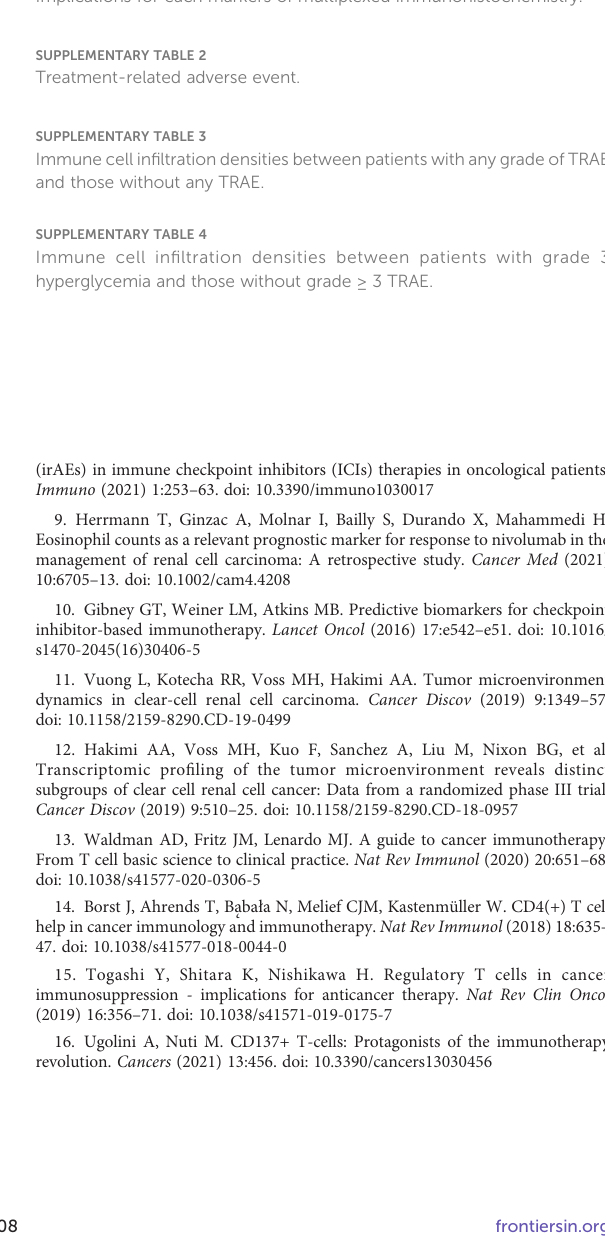
cells, and M1 macrophages, according to the spatial distribution in each available dataset. SUPPLEMENTARY TABLE 1 Implications for each markers of multiplexed immunohistochemistry. SUPPLEMENTARY TABLE 2 Treatment-related adverse event.